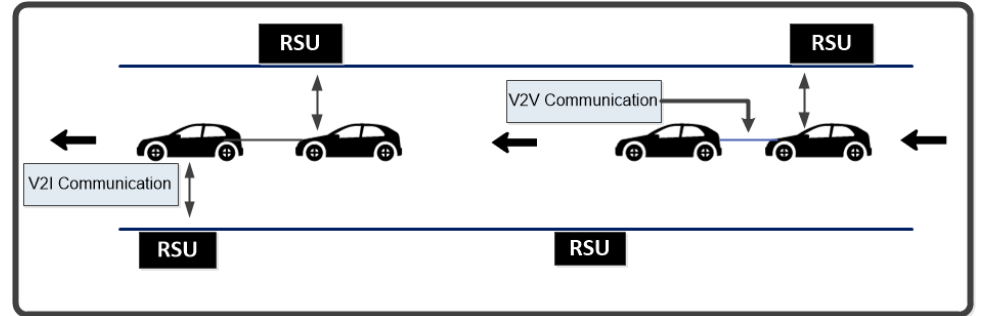
Figure 1. Ad-hoc Network using Vehicles (VANET)